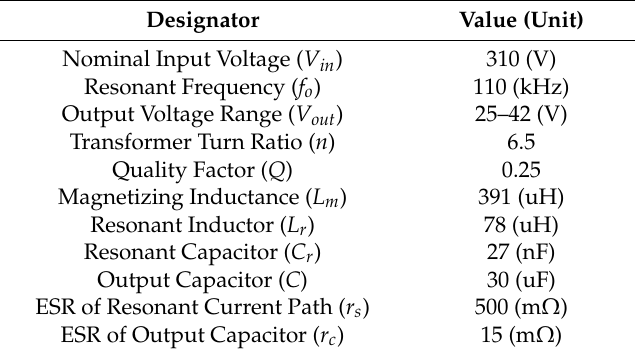
Table 1. Circuit parameters of the LLC resonant battery charger.